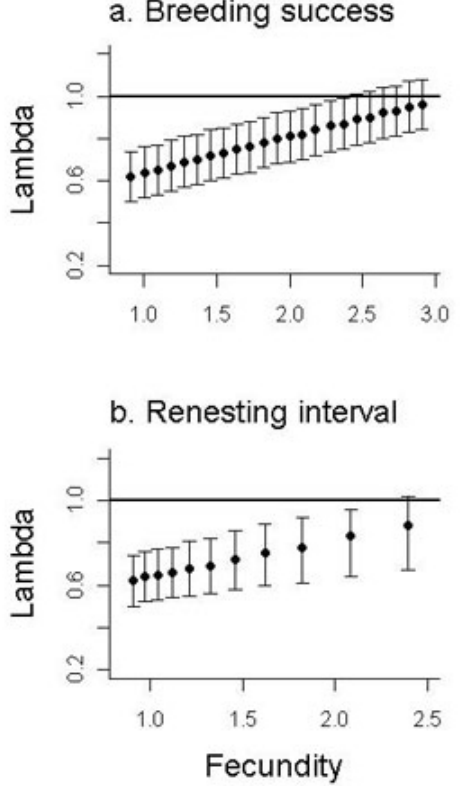
Fig. 4 . Predicted values of fecundity and l for Streaked Horned Larks in western Washington, USA, with successive increases in breeding success (the number of fledglings produced per egg laid; a) and successive decreases in the renesting interval (b). Each point represents a 10% change in the rate. Simulations were conducted until breeding success equaled 100% and the renesting interval equaled 1 day. Only one rate was manipulated at a time; error bars represent ±1 SD. The solid horizontal line represents l =